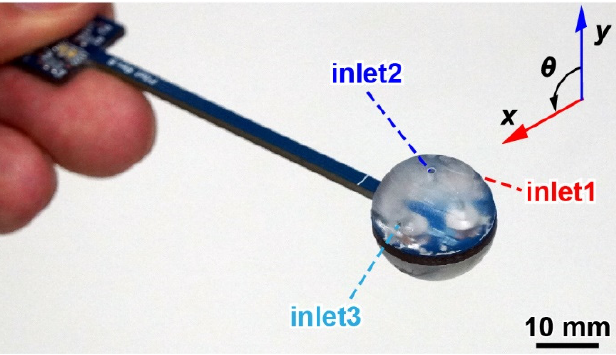
Figure 5. Photograph of the fabricated sphere-shaped airflow vector sensor.